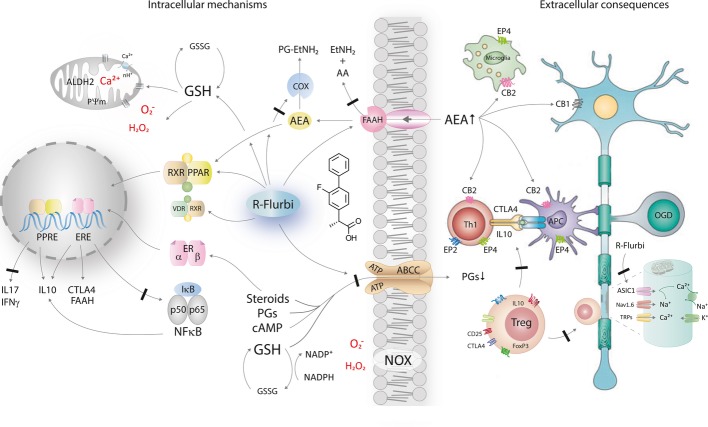
Illustration of R-flurbiprofen's mechanismsR-flurbiprofen reduces hydrolysis and cellular uptake of anandamide (AEA) by fatty acid amide hydrolase (Bishay et al, 2010; Holt & Fowler, 2003) and also inhibits cyclooxygenase-mediated oxidative AEA hydrolysis (Duggan et al, 2011) with a resulting facilitation of actions of AEA at cannabinoid CB1 and CB2 receptors and stronger intracellular AEA-mediated activation of nuclear receptors, PPARγ and PPARα (Bishay et al, 2010). Fortification of AEA likely further involves actions at orphan G-protein coupled receptors including GPR18 [migration of microglia (McHugh, 2012)] and GPR55 [blood-brain barrer (Waldeck-Weiermair et al, 2008)]. R-flurbiprofen also directly activates PPARs and RXR (Bernardo et al, 2005; Bishay et al, 2010) with a resulting increase of anti-inflammatory gene expression and repression of pro-inflammatory genes. R-flurbiprofen inhibits ATP binding cassette efflux transporters including ABCC1 and ABCC4, which transport glutathione, prostaglandins, cyclic nucleotides (cAMP and cGMP) and conjugated steroids (Bai et al, 2004; Brechbuhl et al, 2009; Keppler, 2011; Morrow et al, 2006; Reid et al, 2003; Russel et al, 2008). Efflux inhibition results in an attenuation of prostaglandin release (Geisslinger et al, 2000) but facilitation of intracellular steroid-receptor-mediated effects with an induction of CTLA4 and IL10 and repression of NF-κB and AP-1 (Tegeder et al, 2001), important mechanisms which contribute to the estrogen-receptor-mediated protection in EAE models (Crawford et al, 2010; Khalaj et al, 2013; Kumar et al, 2013; Luna et al, 2010; Saijo et al, 2011; Wu et al, 2013). Blocking the efflux of glutathione will increase the intracellular glutathione pool and increase the antioxidative capacity, which may explain previously observed reductions of lipid peroxidation (Lopez-Villodres et al, 2011), and prevention of mitochondrial calcium overload in stressed cells (Sanz-Blasco et al, 2008) likely contributed by increasing chaperone activity and reduction of ER stress (Hosoi et al, 2014). Collectively, these effects favor the differentiation of regulatory and inflammation-resolving T cells. R-flurbiprofen also inhibits hydrogen sensitive ASIC1 channels (Mishra et al, 2010; Voilley et al, 2001), which contribute to pathological firing of demyelinated axons, and ASIC1 inhibition is neuroprotective in EAE models (Arun et al, 2013; Friese et al, 2007).